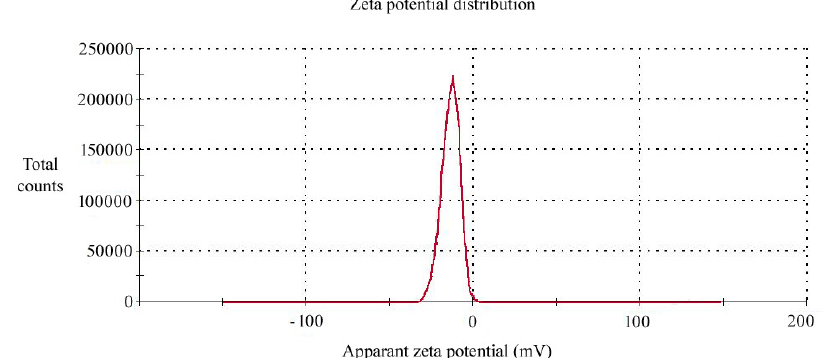
Fig. 10. DLS zetapotential of G. applanatum extract mediate